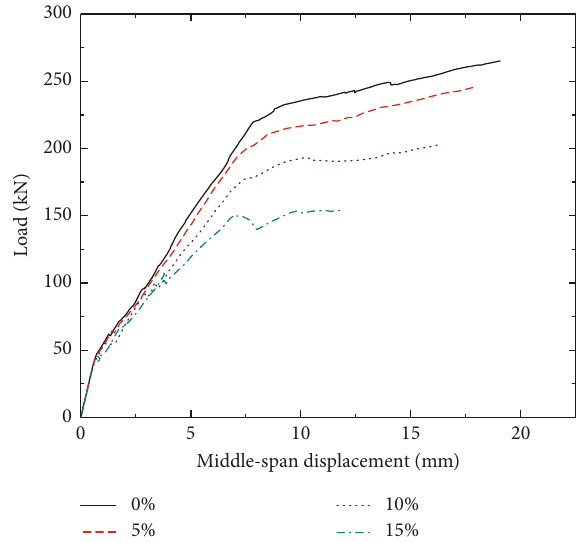
Figure 13: The load-displacement curve of beams due to